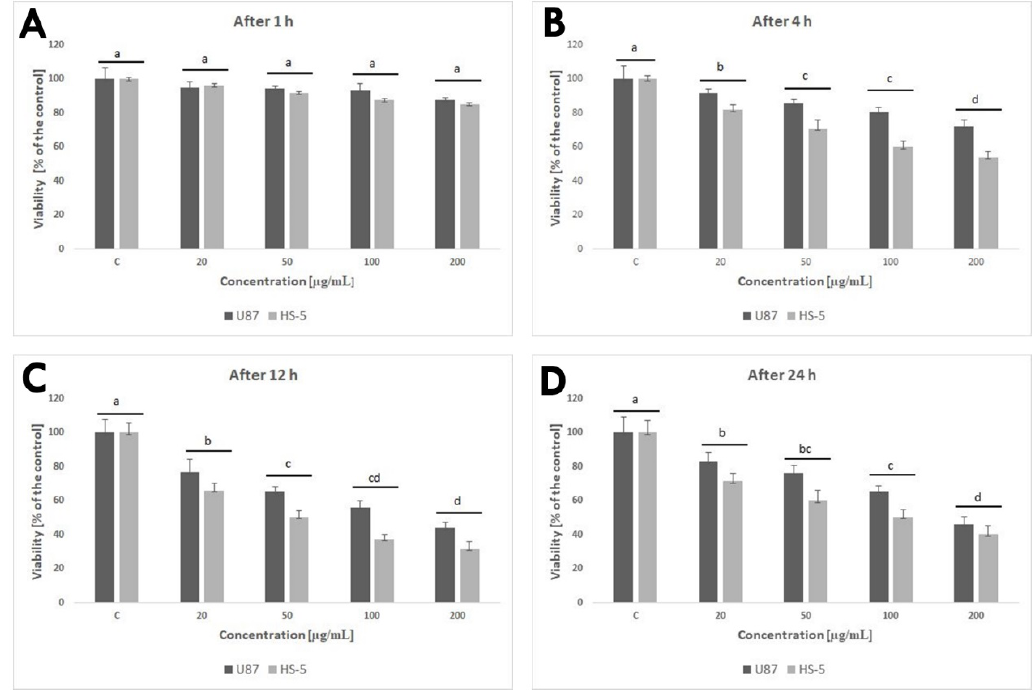
Figure 4. Effect of pristine graphene on the viability of U87 and HS-5 cells after 1 ( A ), 4 ( B ), 12 ( C ), and 24 ( D ) h. Notes: The columns with different letters (a–d) indicate significant differences between the concentrations; error bars are standard deviations. C—control group (untreated cells).